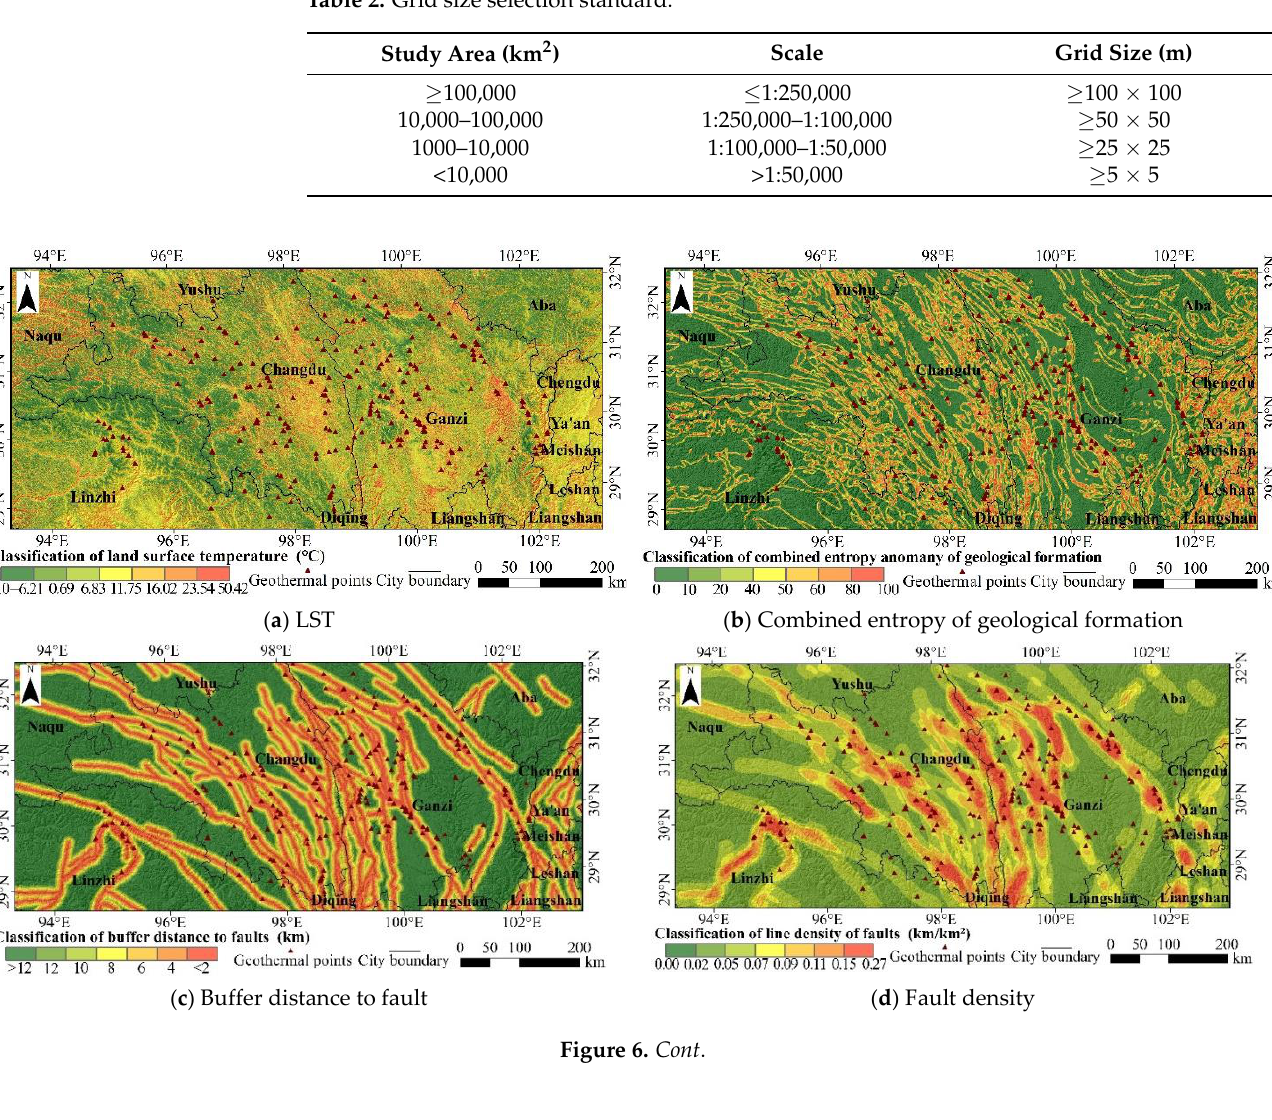
Table 2. Grid size selection standard.